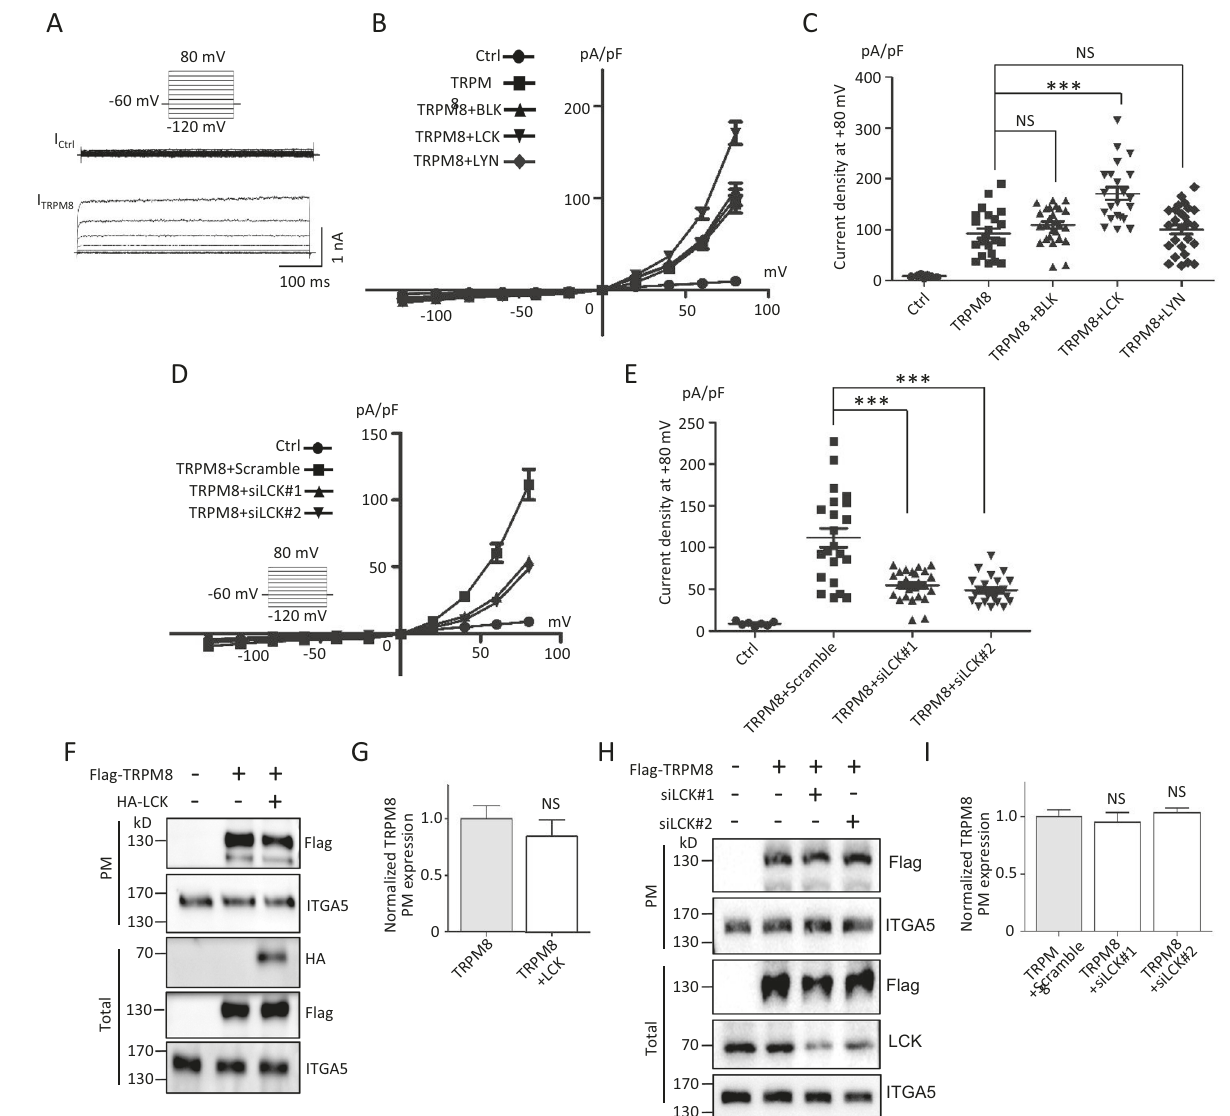
Fig. 2 Functional effects of LCK on TRPM8 in HEK293T cells. A – E Electrophysiological analysis of LCK on whole-cell TRPM8 currents (I TRPM8 ) by patch-clamping experiments. A – C Expression constructs for Flag-TRPM8 and pEGFP-N1 were co-transfected with HA-BLK, HA-LCK, HA-LYN, or control vector into HEK293T cells. EGFP-positive cells were selected for recording I TRPM8 ( n = 5~20 cells per group). The voltage clamp protocol is shown in the inset of fi gure. A Representative imaging of I TRPM8 . B The relationship of average I TRPM8 densities (I TRPM8 normalized to cell capacitance) and voltage. C Quanti fi cation of peak I TRPM8 density on + 80 mV as in ( B ). D , E Similar I TRPM8 recordings as in ( A ) but HEK293T cells co-expressing Flag-TRPM8 and pEGFP-N1 with siLCK or negative scramble siRNAs. ( n = 5~20 cells per group). D The relationship of average I TRPM8 densities and voltage. E Quanti fi cation of peak I TRPM8 density on + 80 mV as in ( D ). F – I Cell ‐ surface biotinylation assays for detecting TRPM8 PM expression. F Representative WB images of TRPM8 on the PM and total lysates from HEK293T cells co-transfected with or without HA-LCK. G Quanti fi cation of PM protein expression levels of TRPM8 in ( F ). H , I Similar experiments in ( F ) and ( G ) but cells co-expressing with siLCK or negative scramble siRNAs. ITGA5 (Intergrin α 5) was used as a loading control for PM proteins. *** P < 0.001, NS not signi fi cant. Data are presented as mean ± SEM. All studies were repeated at least three